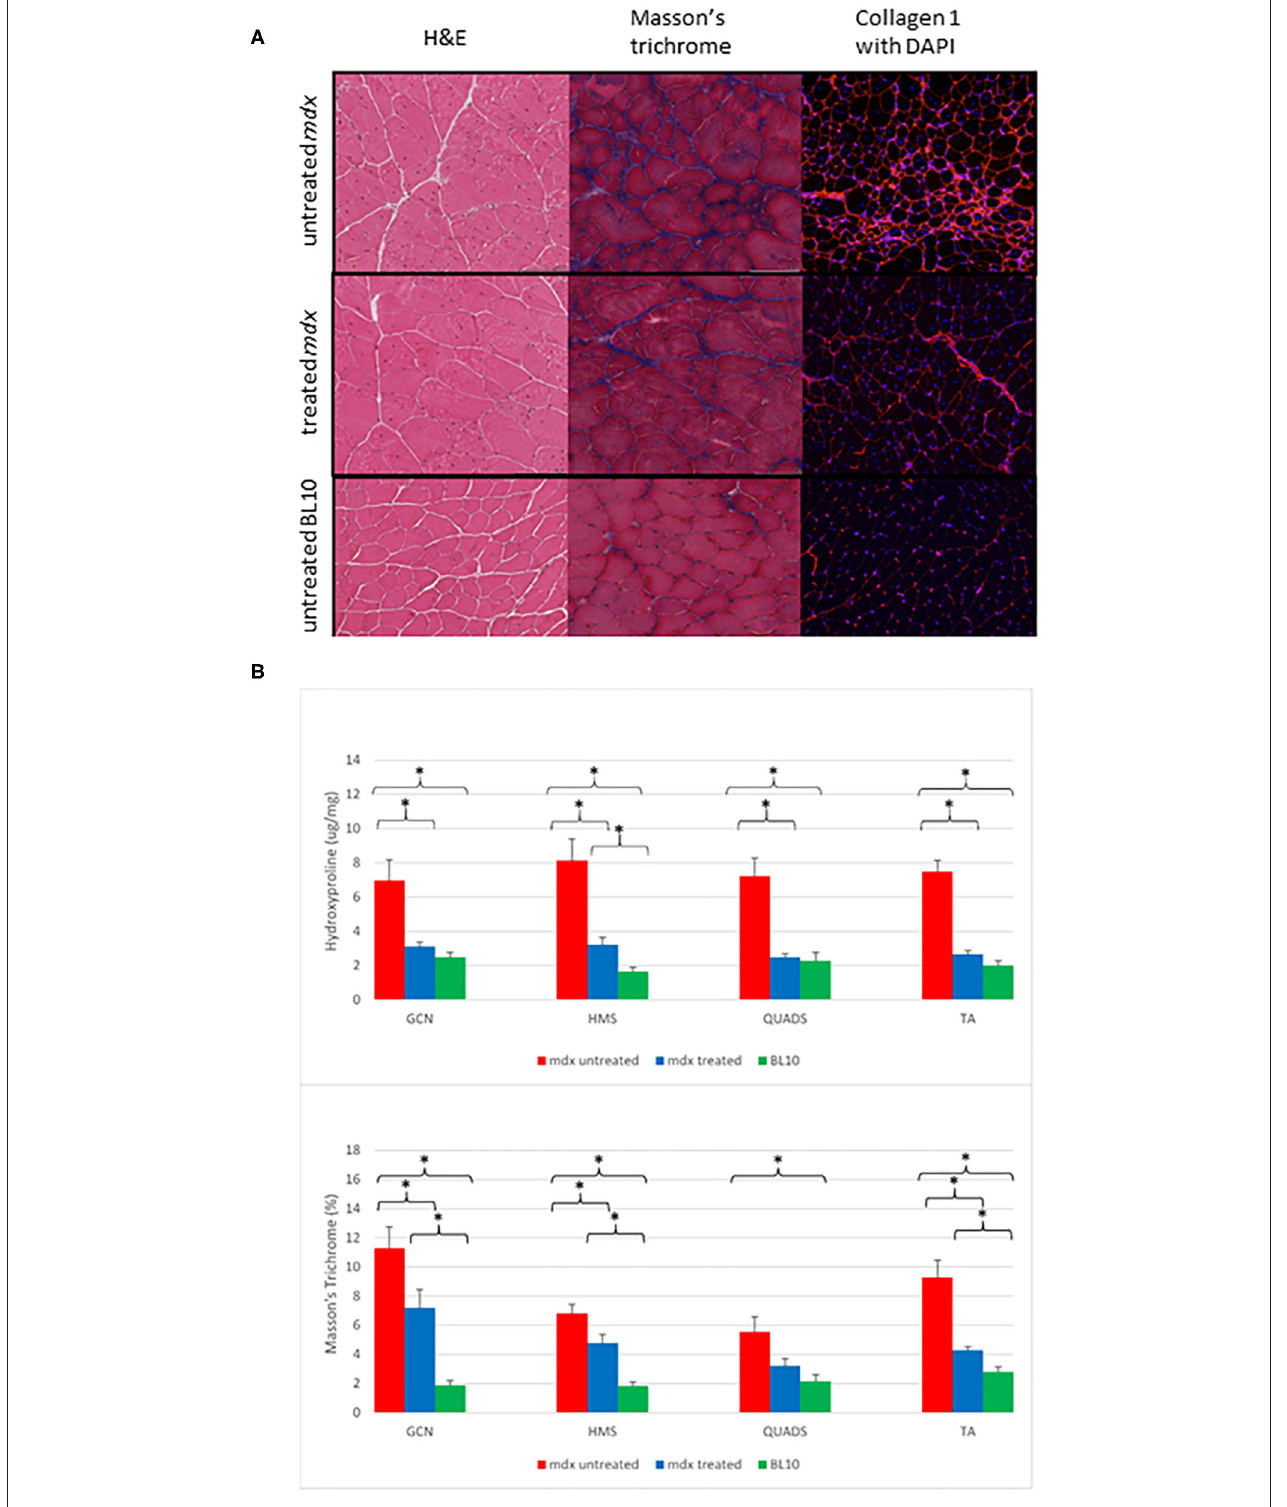
FIGURE 2 | (A) Examples of transverse sections from gastrocnemius (GCN) muscles. The left column shows H&E staining at × 20 magnification demonstrate that the mdx mouse groups have evidence of more centrally located nuclei, varying myocyte size and areas of fibrosis (white). The middle column